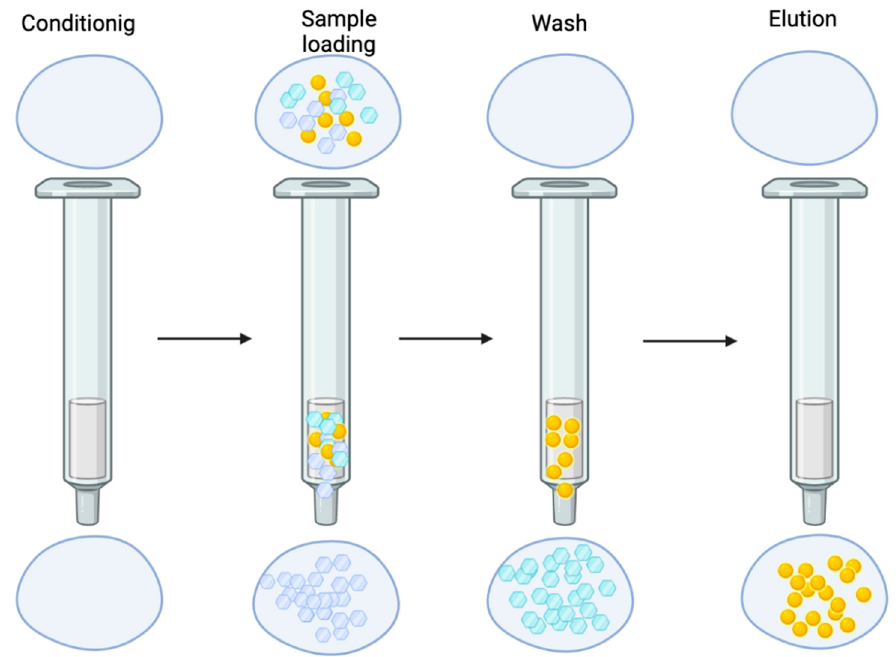
Figure 2. SPE consists of four critical steps, in which a solid sorbent is pre-conditioned with an appropriate solvent to remove possible impurities, wetting the packed material, and solvation of the functional groups. 1—The conditioning solvent must be selected depending on the nature of the solid sorbent; 2—The second step consists of loading the sample through the solid sorbent. 3—The third step is the optional washing of the sorbent to eliminate the residual compounds retained by the sorbent; 4—The final step involves the elution of the analytes of interest with an appropriate solvent.